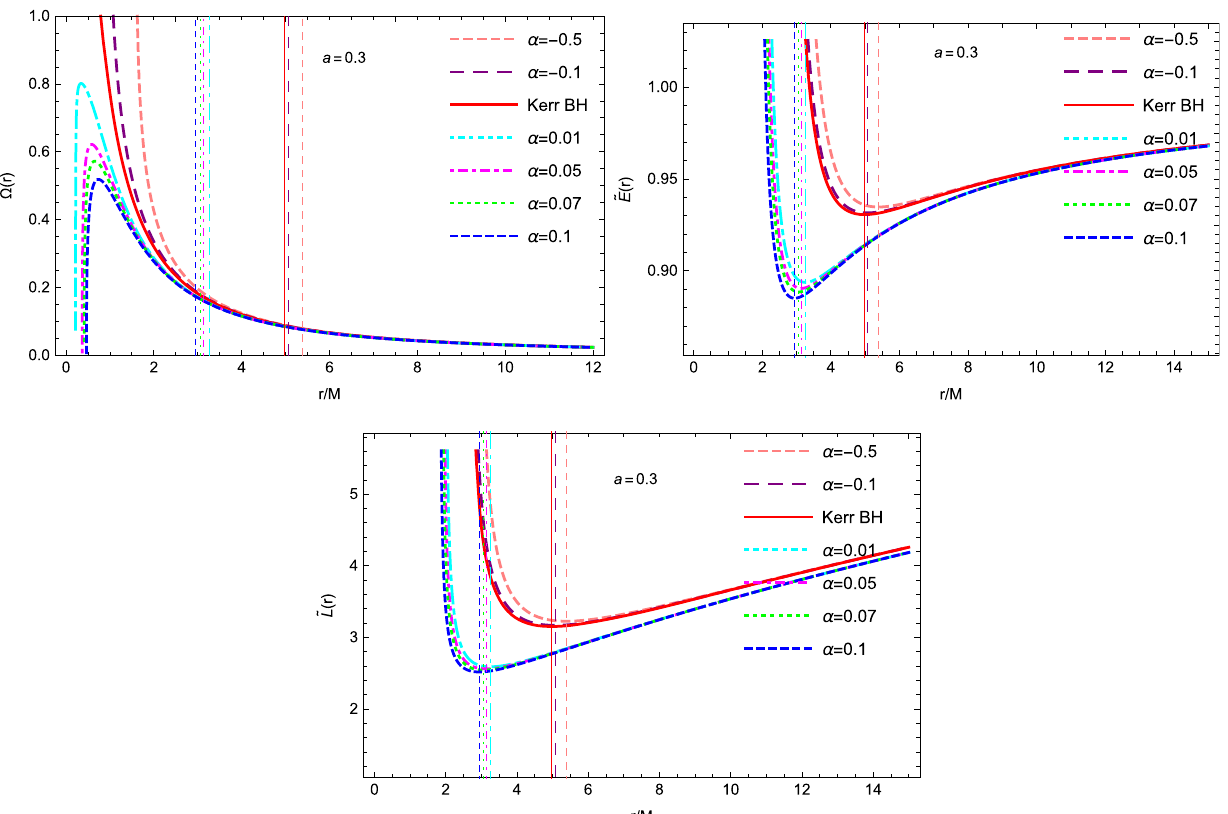
Fig. 2 Theangularvelocity (cid:8)( r ) (top-leftpanel),specificenergy ˜ E ( r ) (top-right panel) and specific angular momentum ˜ L ( r ) (bottom panel) of a rotating 4 D EGB BH with total mass M = 2 . 5 × 10 6 M (cid:8) shown as a function of the radial coordinate r for different values of α and